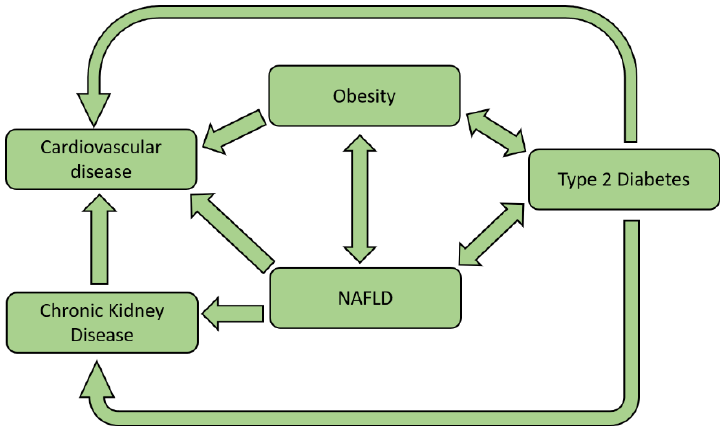
Figure 3. Schematic representation of NAFLD associated cardiorenal disease and type 2 diabetes development.